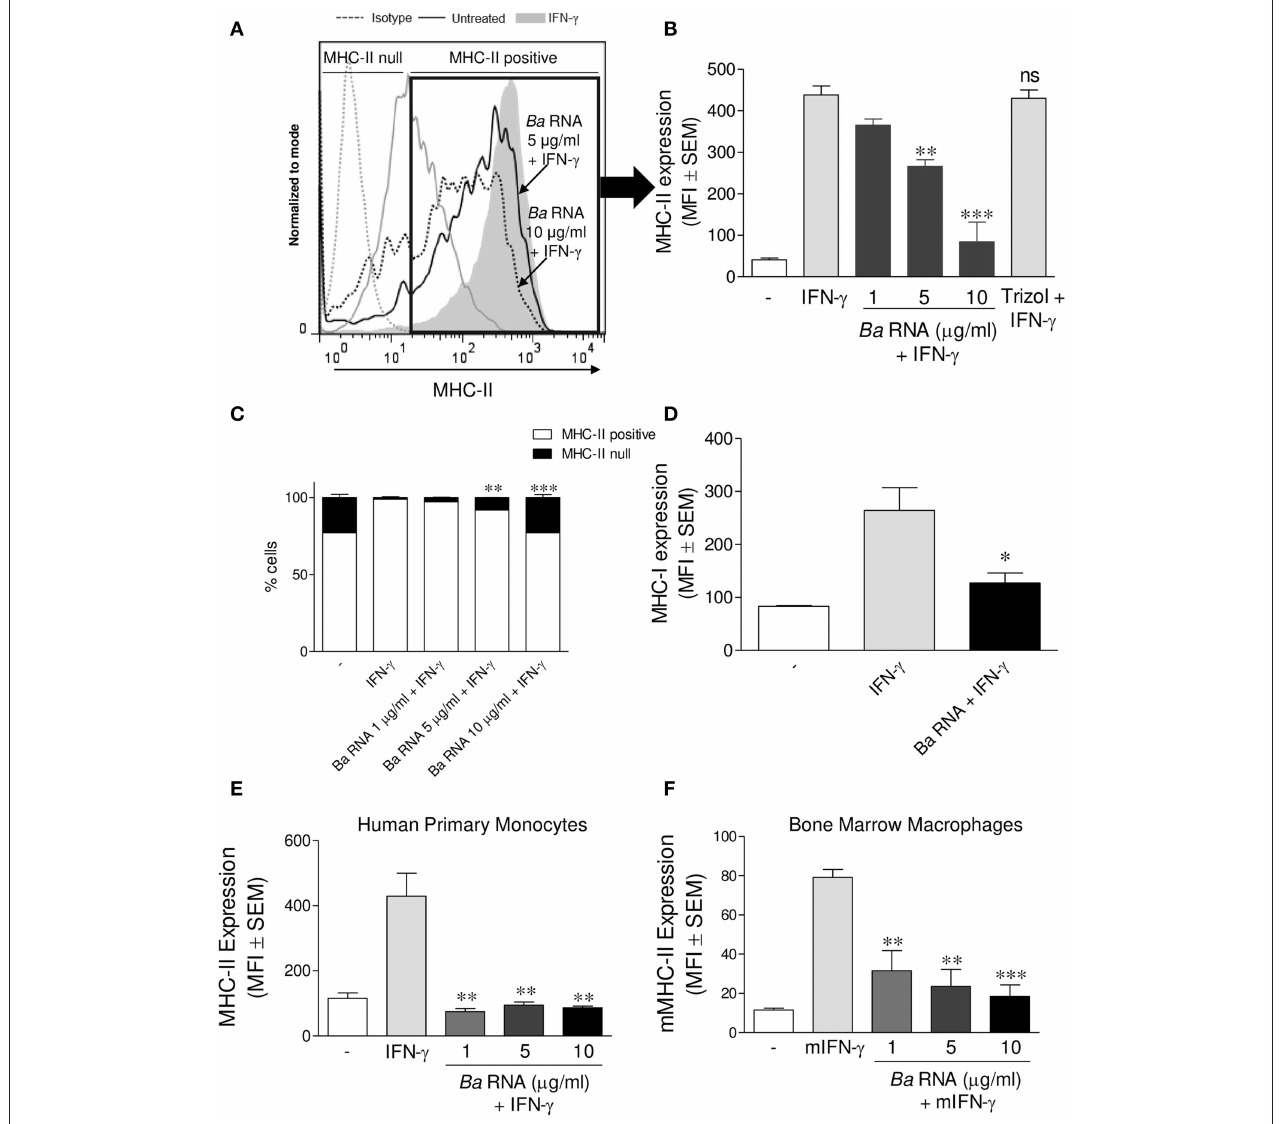
FIGURE 1 | B. abortus RNA down-modulates MHC-II on monocytes/macrophages. (A,B) THP-1 cells were treated with different doses of B. abortus RNA in the presence of IFN- γ for 48h. MHC-II expression was evaluated by flow cytometry. (A) Flow cytometry histograms (showing MHC-II positive and null cells) representative of bars showed in (B) . (B) Bars represent the arithmetic means ± SEM of MHC-II positive cells corresponding to five independent experiments. Trizol extracted products in the absence of bacteria were used as a control. (C) Quantification of cells expressing MHC-II (MHC-II positive cells) or not (MHC-II null). Data is expressed as the percentage of cells ± SEM of three independent experiments. (D) THP-1 cells were treated with B. abortus RNA (10 µ g/ml) in the presence of IFN- γ for 48h. MHC-I expression was evaluated by flow cytometry. (E,F) Peripheral blood-purified monocytes (E) and bone marrow macrophages (F) were stimulated with different doses of B. abortus RNA in the presence of IFN- γ for 48h. MHC-II expression was assessed by flow cytometry. Bars represent the arithmetic means ± SEM of five independent experiments. MFI, mean fluorescence intensity; mIFN- γ , murine IFN- γ . ns, non-significant. * P < 0.05; ** P < 0.01 ; *** P < 0.001 vs. IFN- γ -treated